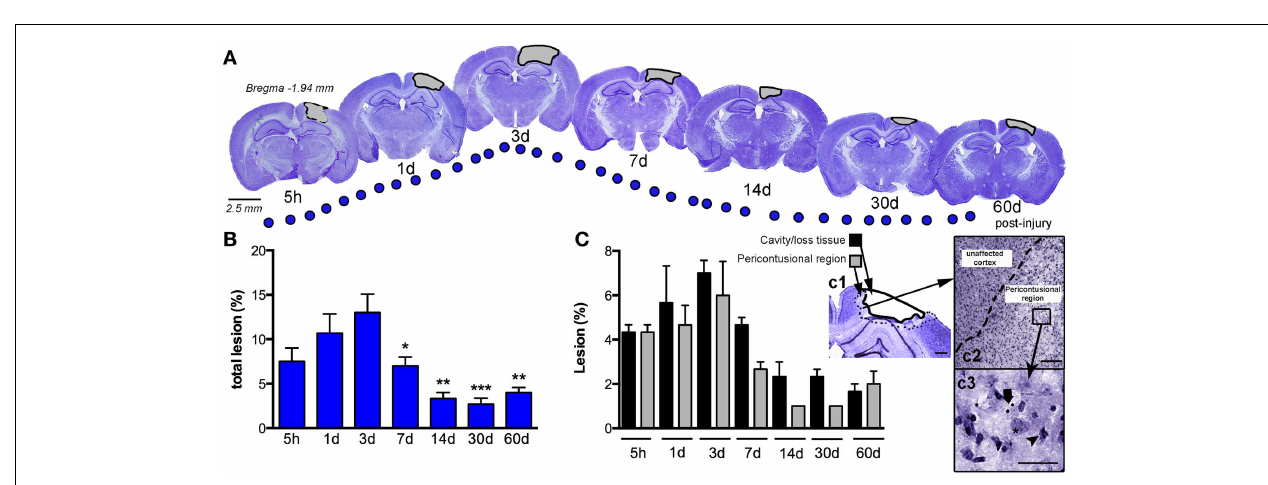
ipsilateral hemisphere at different times post-injury. (c1) Representative images showing the delimited damaged cortical regions corresponding to cavity or tissue loss or the pericontusional region. High magnification image of the unaffected cortex and pericontusional region (c2) containing apoptotic cells (c3, arrow) and chromatin condensate (c3, arrowhead). Scale bar; 100 µ m (c1), 50 µ m (c2), and 20 µ m (c3).Values are expressed as